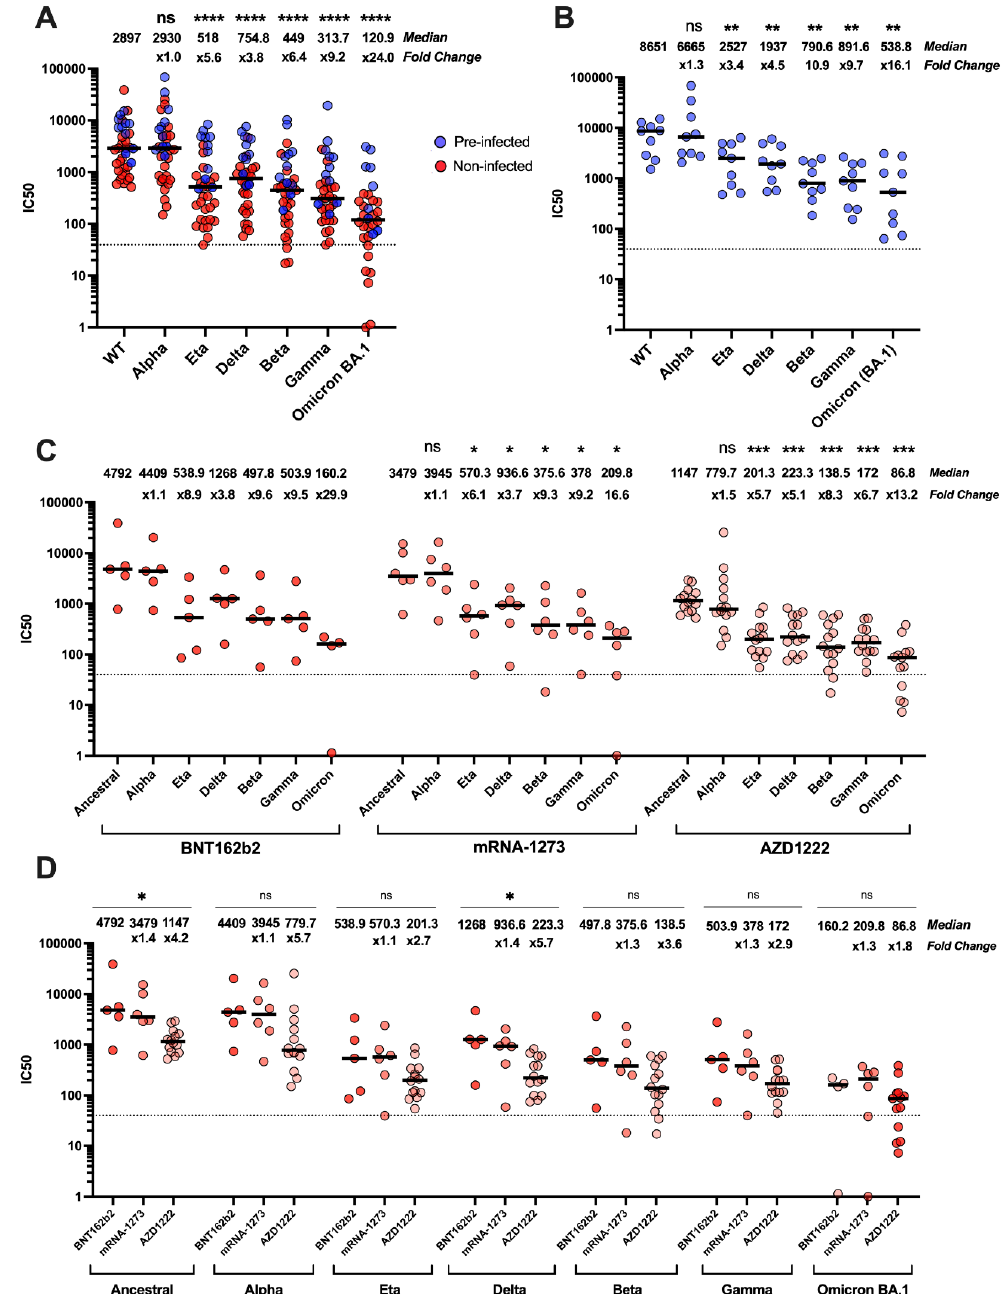
Figure 3. Ability of serum antibodies to neutralise SARS-CoV-2 and VOCs from individuals vaccinated with two doses of either BNT162b2, AZD1222, or mRNA-1273. Neutralizing antibody response against the ancestral SARS-CoV-2 and variants, in previously infected individuals (blue) and non-infected individuals (red) receiving two doses of either BNT162b2, AZD1222, or mRNA-1273 vaccines ( A ). Wilcoxon matched-pairs signed rank tests statistical analysis was used to compare ancestral SARS-CoV-2 against each variant ( A ). Neutralisation profiles of sera from BNT162b2-vaccinated subjects with a history of prior infection. No statistical test was used for BNT162b2 in panel C due to small sample size with large variation. ( B ). Neutralisation profiles of the three vaccine types against variants ( C ) and compared between vaccine platforms. ( D ) Wilcoxon matched-pairs signed rank tests statistical analysis was used to compare ancestral SARS-CoV-2 against each variant in panel C. Kruskal–Wallis ANOVA was used for statistical analysis in panel D. ns = not significant, * p < 0.05, ** p < 0.01, *** p < 0.001, **** p ≤